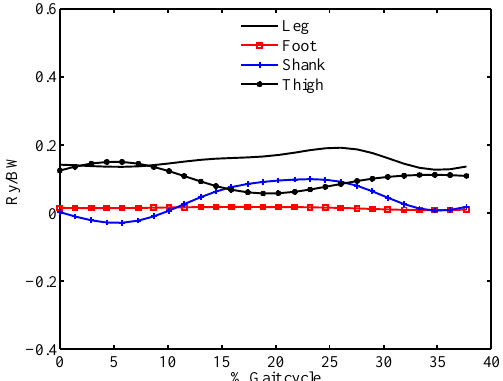
Figure 9. Contributions from foot, shank and thigh of the swing leg and sum of all three (Leg) to GRFy is SS phase as a fraction of body weight with AFROS.The results from the model with FROS are similar. (Gait cycle starts at toe-off of the other leg, that is, at the beginning of SS.)